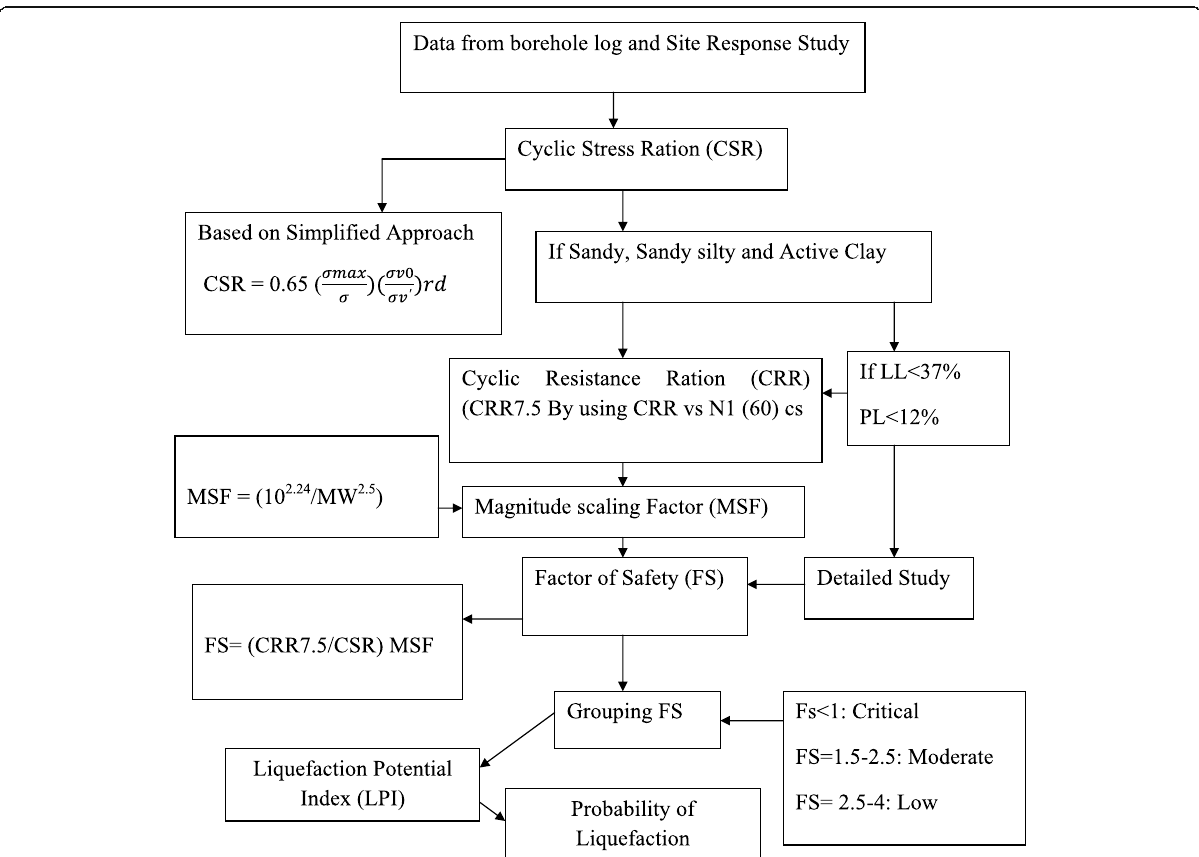
Fig. 10 Steps to be involved in the evaluation of factor of safety against liquefaction (modified after Anbazhagan